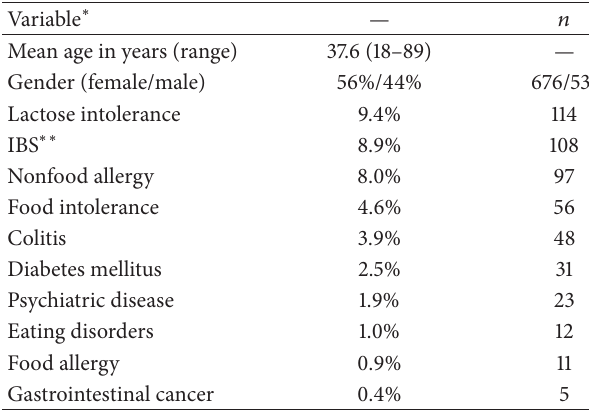
Table 1: Demographics and clinical characteristics of the studied population.